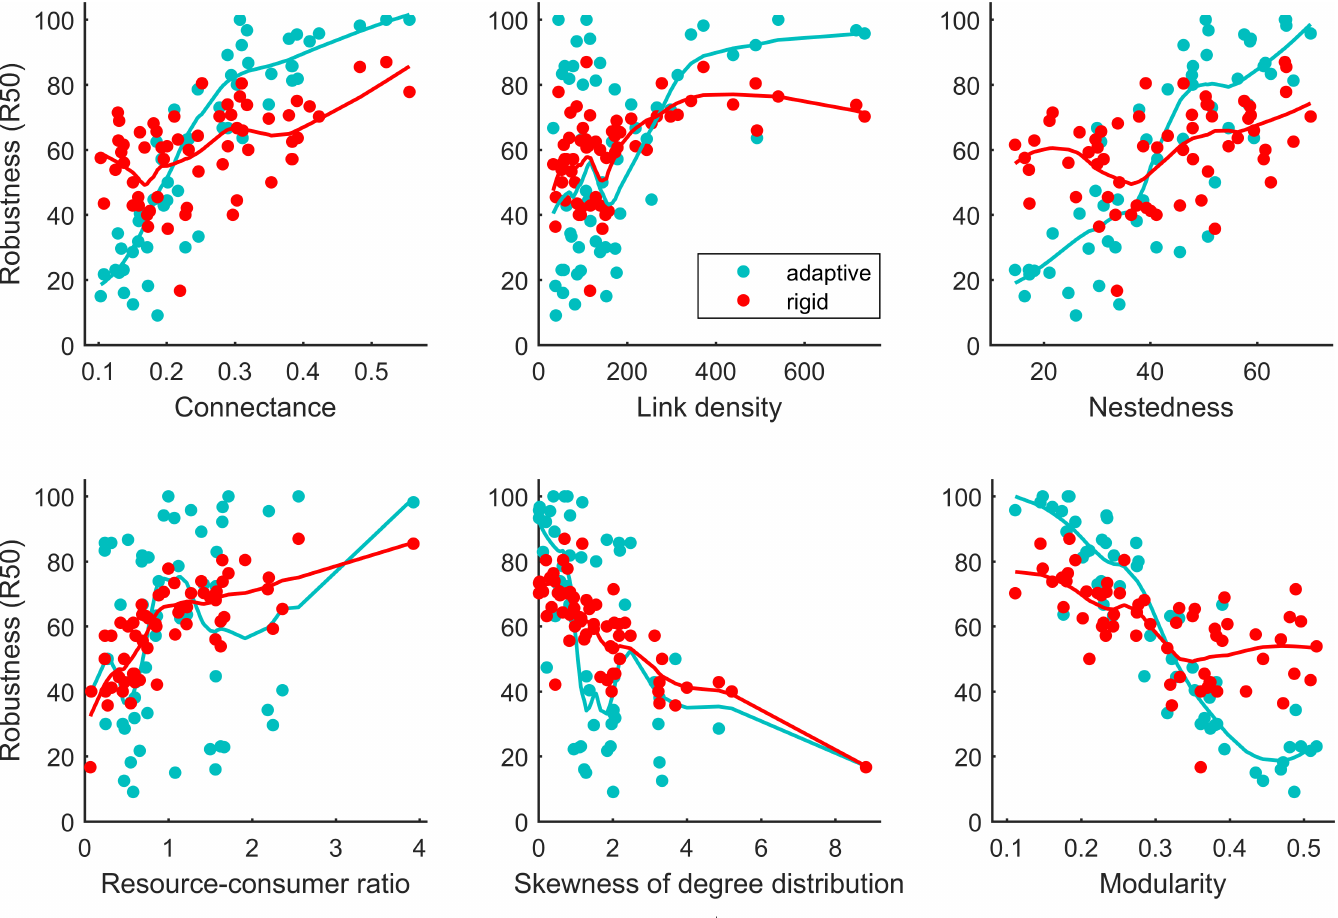
Fig 2. Robustness vs. network structure. For each simulation, the model was ran up t = 150, after which its structure was recorded. The generalist species were sequentially removedand the level of robustness recorded. Panelsshow the relationshipbetweenrobustness and connectance, link density, nestedness,resource-consumerratio, skewnessof the degreedistribution and modularityin both adaptiveand rigid networks. R50 was used as the measure of robustness. Cyan lines indicateregressionsfor adaptive networks(cyan dots) while red lines for rigid networks (red dots). Spearman’srank correlationcoefficients are summarised in Table